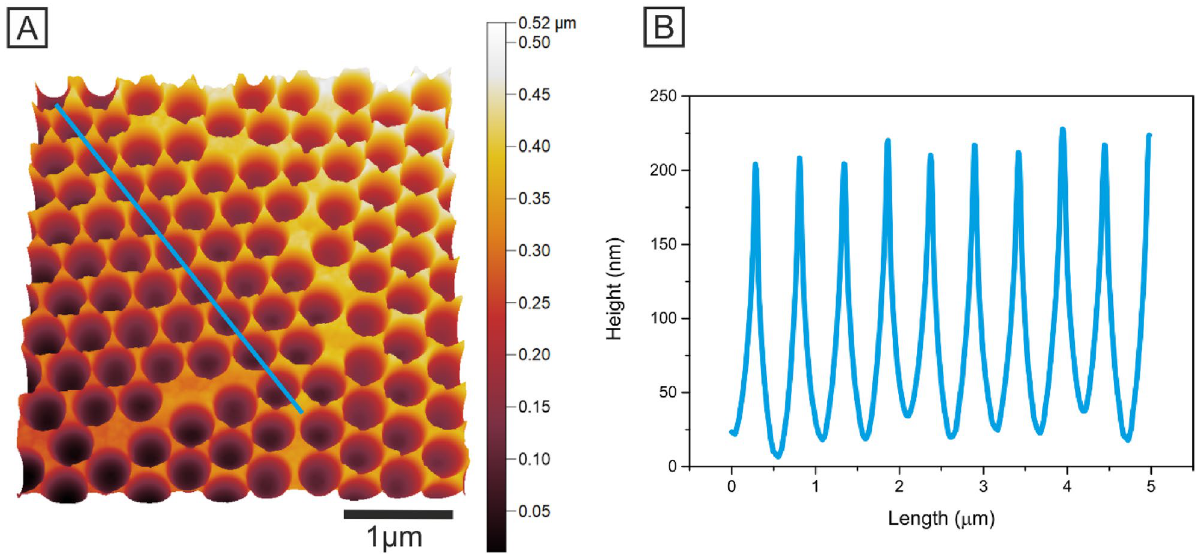
Figure 2. AFM image of Ni nanocavities ( A ) and the height profile obtained from the AFM image along the marked blue line ( B